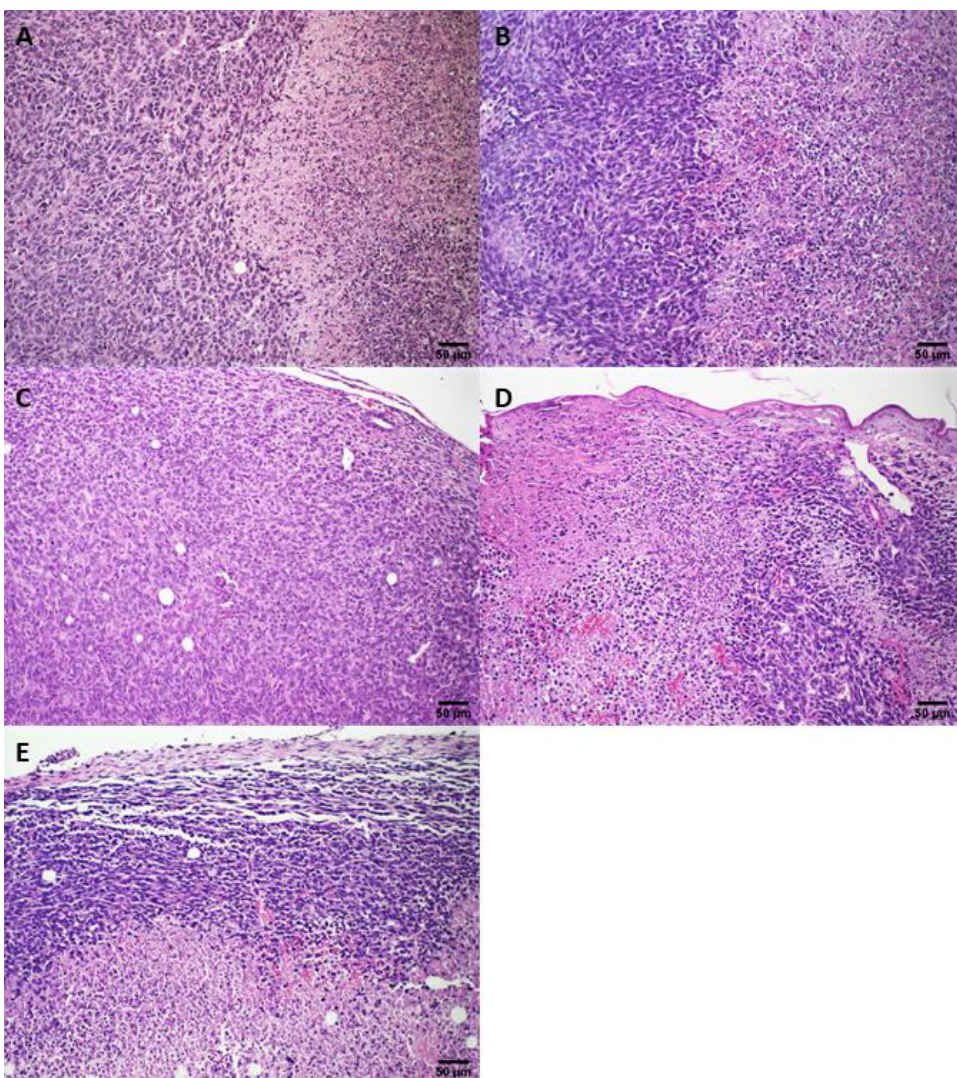
Figure A7. Histological sections of primary tumor of female Balb/c mice bearing 4T1 breast tumors treated with ( A ) control group (HBS), ( B ) ExoSpHL, or ( C ) DOX at a cumulative dose of 25 mg/kg, ( D ) SpHL-DOX at a cumulative dose of 25 mg/kg, ( E ) ExoSpHL-DOX at a cumulative dose of 25 mg/kg.